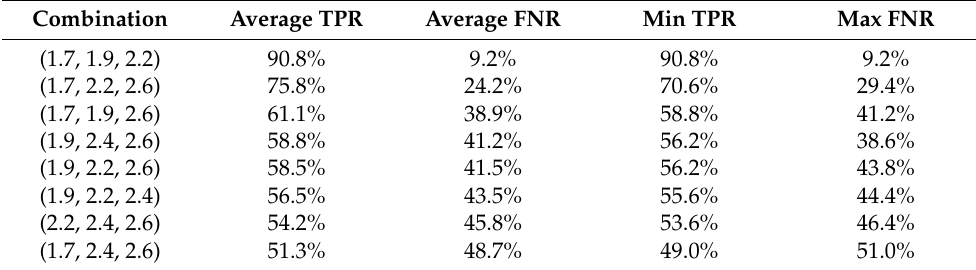
Figure 4. Confusion matrix for the classification of PP (class 1) and PE (class 2). The results of the optimization are shown in Table 2. Table 2. Classification rates of different combinations of the 5 InGaAs available sensors.